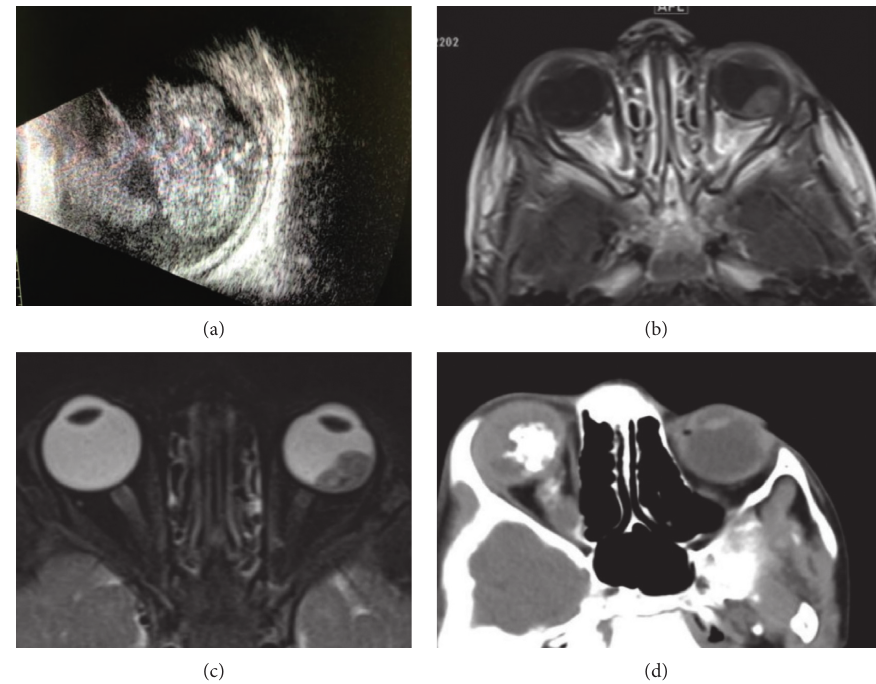
Figure 3: Different imaging modalities used to visualise retinoblastoma [15]. (a) B scan of an eye with diffuse pattern retinoblastoma showing areas of calcification (see left) reproduced from Fahad Albader and Dalal Fatani 2019, (under the Creative Commons Attribution 3.0 License). (b) MRI T1-weighted image with contrast, faintly enhanced retrolental mass at left globe corresponding to retinoblastoma tumor core [see left] reproduced from Fahad Albader and Dalal Fatani 2019, [under the Creative Commons Attribution 3.0 License]. (c) MRI T2-weighted fat saturated image of the orbits showing low signal of retrolental mass corresponding to retinoblastoma tumor at the left globe with mild reduction of size of globe (see left) reproduced from Fahad Albader and Dalal Fatani 2019, (under the Creative Commons Attribution 3.0 License). (d) CT (soft tissue window image) showing right globe hyperdense vitreous, retrolental intraocular solid mass with dystrophic calcification and proximal calcified optic nerve local invasion (see left) reproduced from Fahad Albader and Dalal Fatani 2019, [under the Creative Commons Attribution 3.0